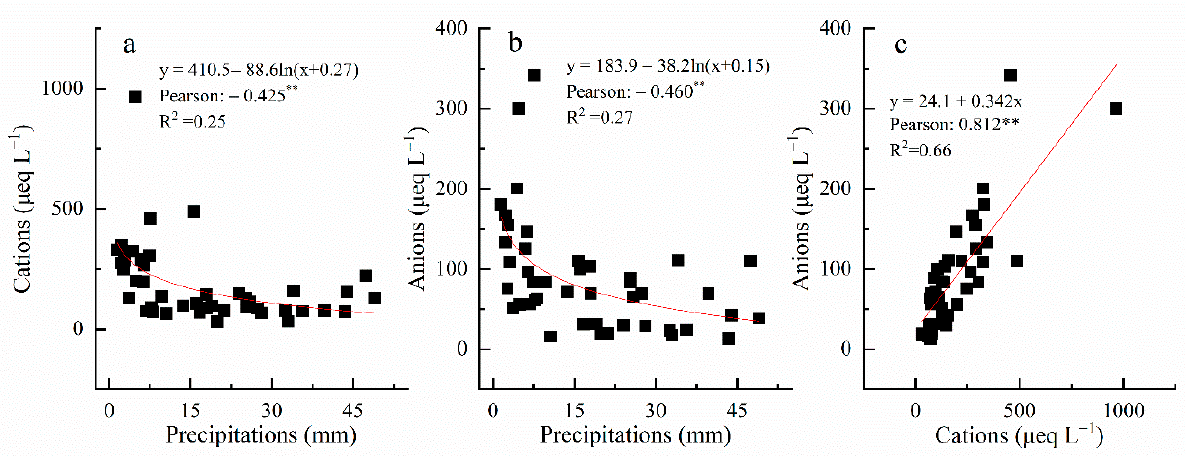
Figure 5. Relationship between precipitation amounts and cations ( a ), precipitation amounts and anions ( b ), and cations and anions ( c ). The symbol ** represents significance at 0.01 level. Table 1. Source contributions (%) for major ions in